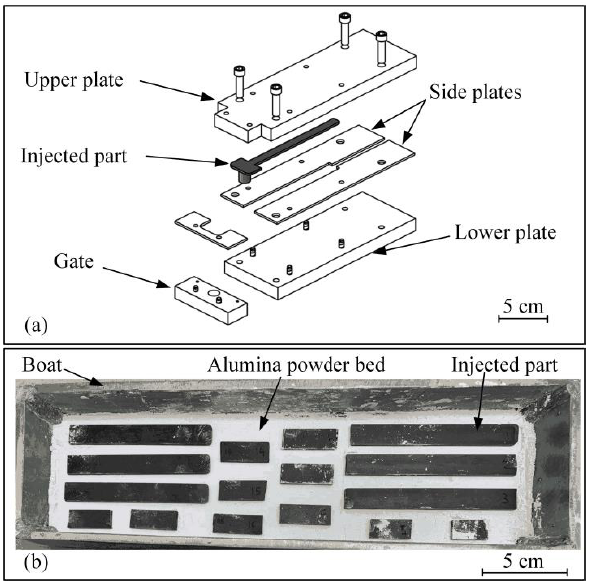
Figure 2. ( a ) Schematic representation of the rectangular mold and ( b ) typical arrangement of the injected parts settled on an alumina powder bed before debinding (top layer of alumina powder is not shown).